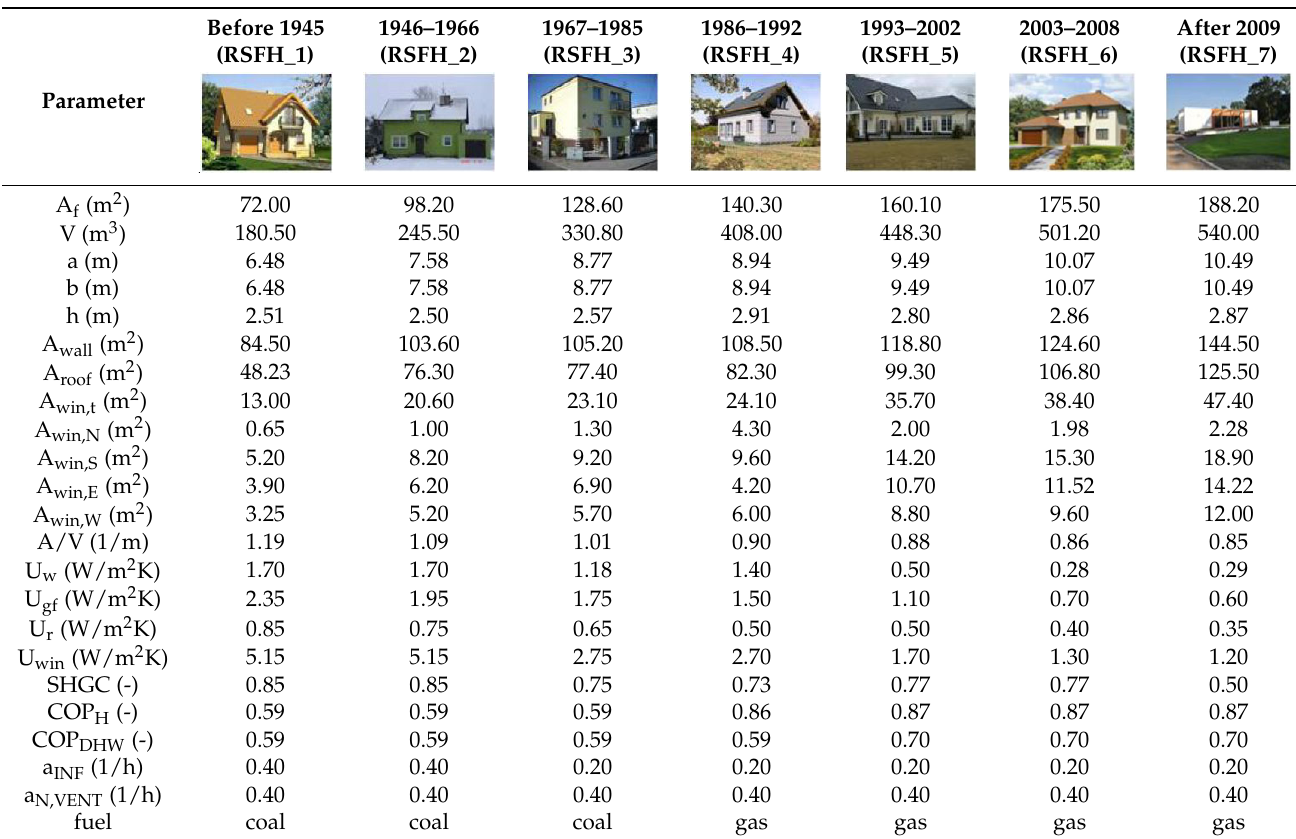
Table 2. Main geometry parameters and energy characteristics of the Polish RSFH (source [40]).